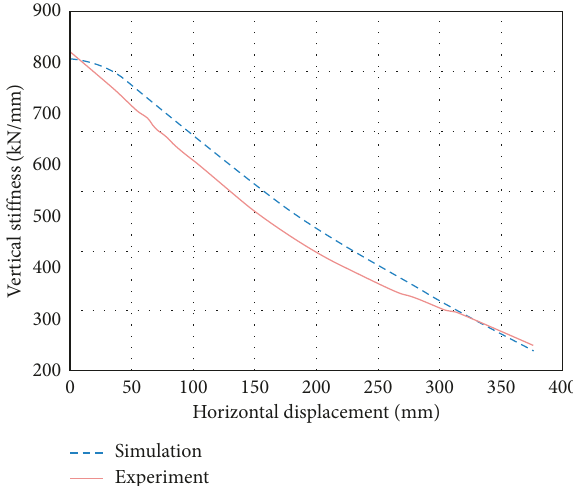
Figure 33: Comparison of vertical stiffness-horizontal displace- ment relationship curve.